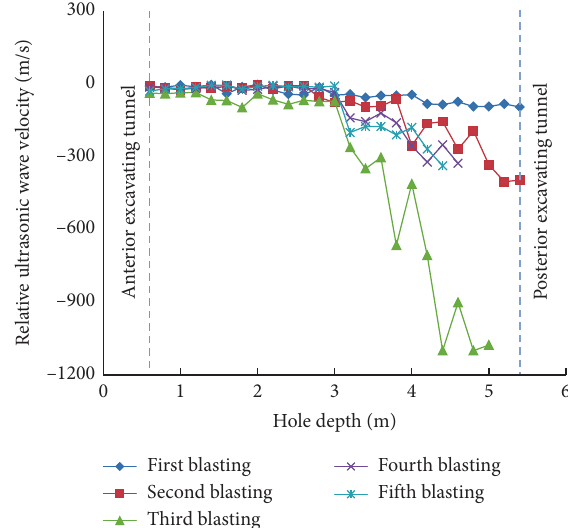
Figure 8: Relation curves between relative ultrasonic wave velocity and hole depth ( L 1).